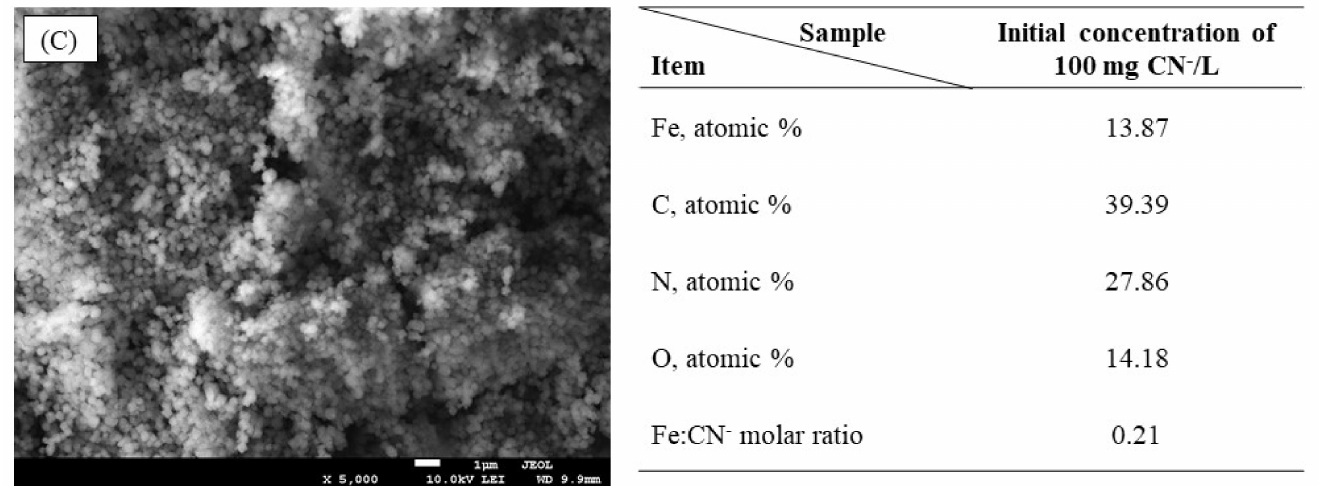
Figure 6. ( A ) CN − removal as a function of Fe:CN − molar ratio for various initial concentration. ( B ) XRD powder pattern and ( C ) SEM observation of the precipitate produced at initial concentration of 100 mg CN − /L and the theoretical Fe:CN − molar ratio of 0.5. Control pH of 7. Current intensity of 1 A. Mechanical